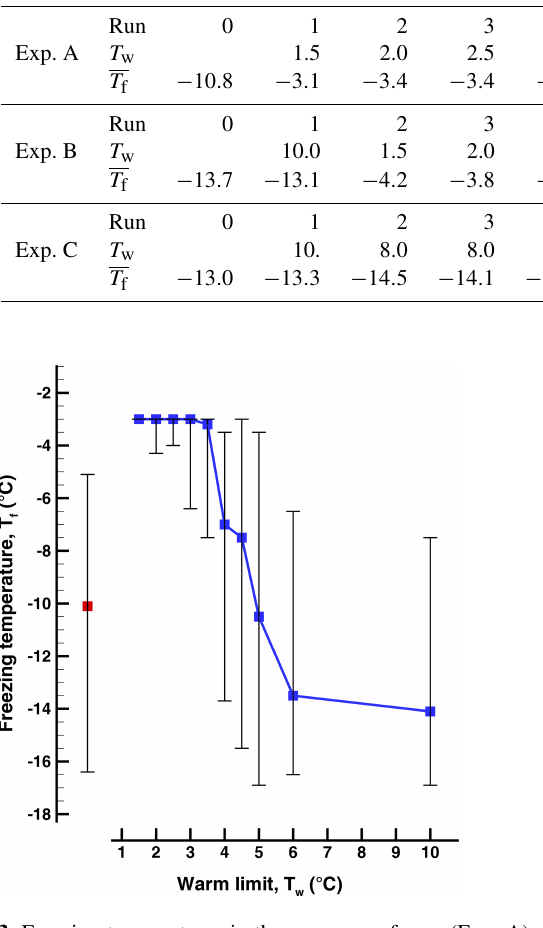
Figure 4. Freezing temperatures in a sequence of runs (Exp. B) with increasing warm limit, T w , after run 1 with T w = + 10 ◦ C. Run 0 was started at room temperature. The 50% value is indicated by the square symbols, and the vertical lines show the 5th- and 95th- percentile